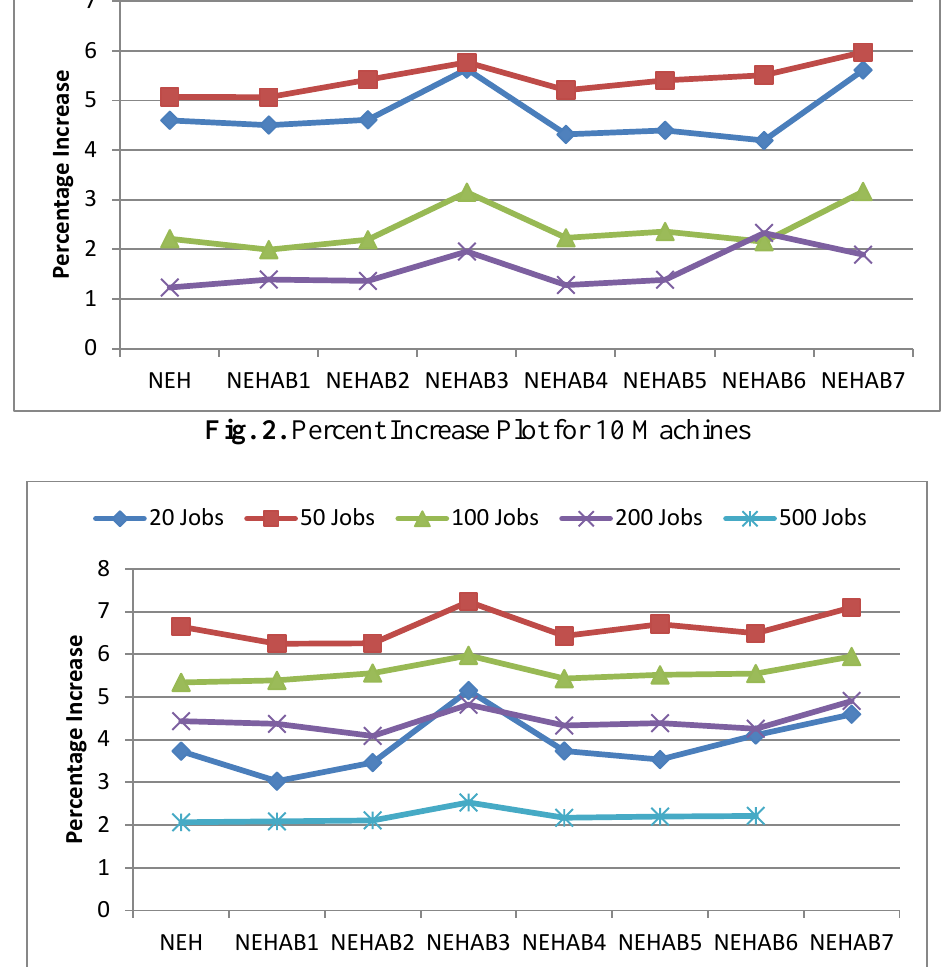
Fig. 3. Percent Increase Plot for 20